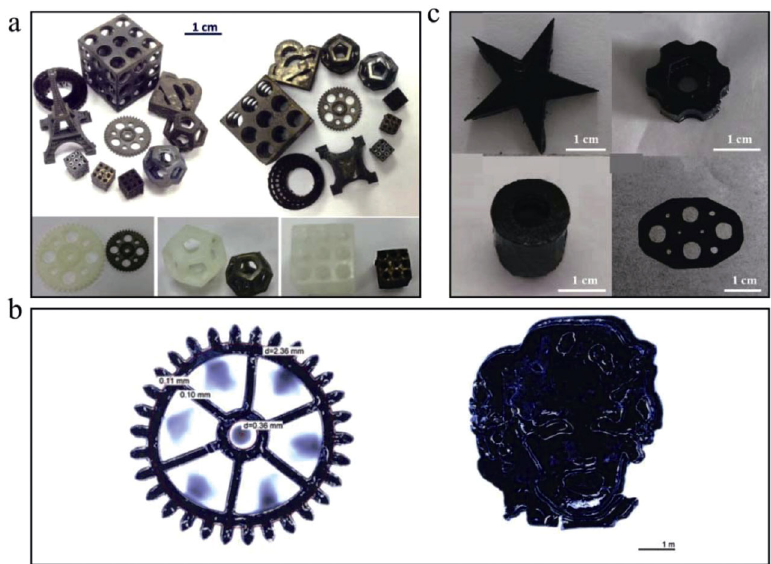
Fig. 27 SLA of polymer-derived ceramics: (a) SiC-rich ceramic. Reproduced with permission from Ref. [79], © Elsevier Ltd. 2017. (b) SiCN ceramic. Reproduced with permission from Ref. [80], © Elsevier Ltd and Techna Group S.r.l. 2018. (c) SiC ceramic. Reproduced with permission from Ref. [81], © Elsevier Ltd and Techna Group S.r.l.